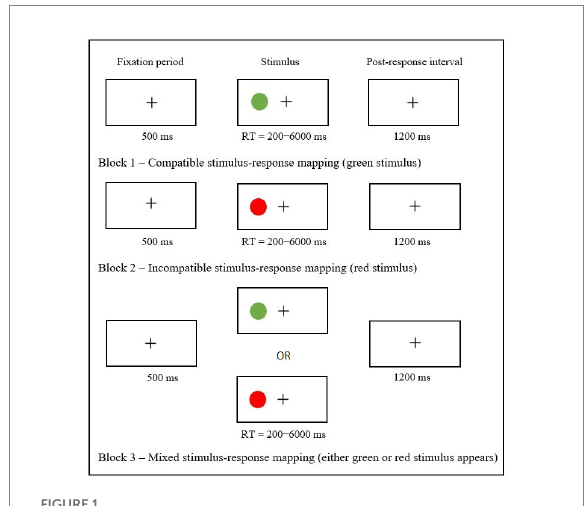
FIGURE 1 Schematic overview of the Response Organization Objects